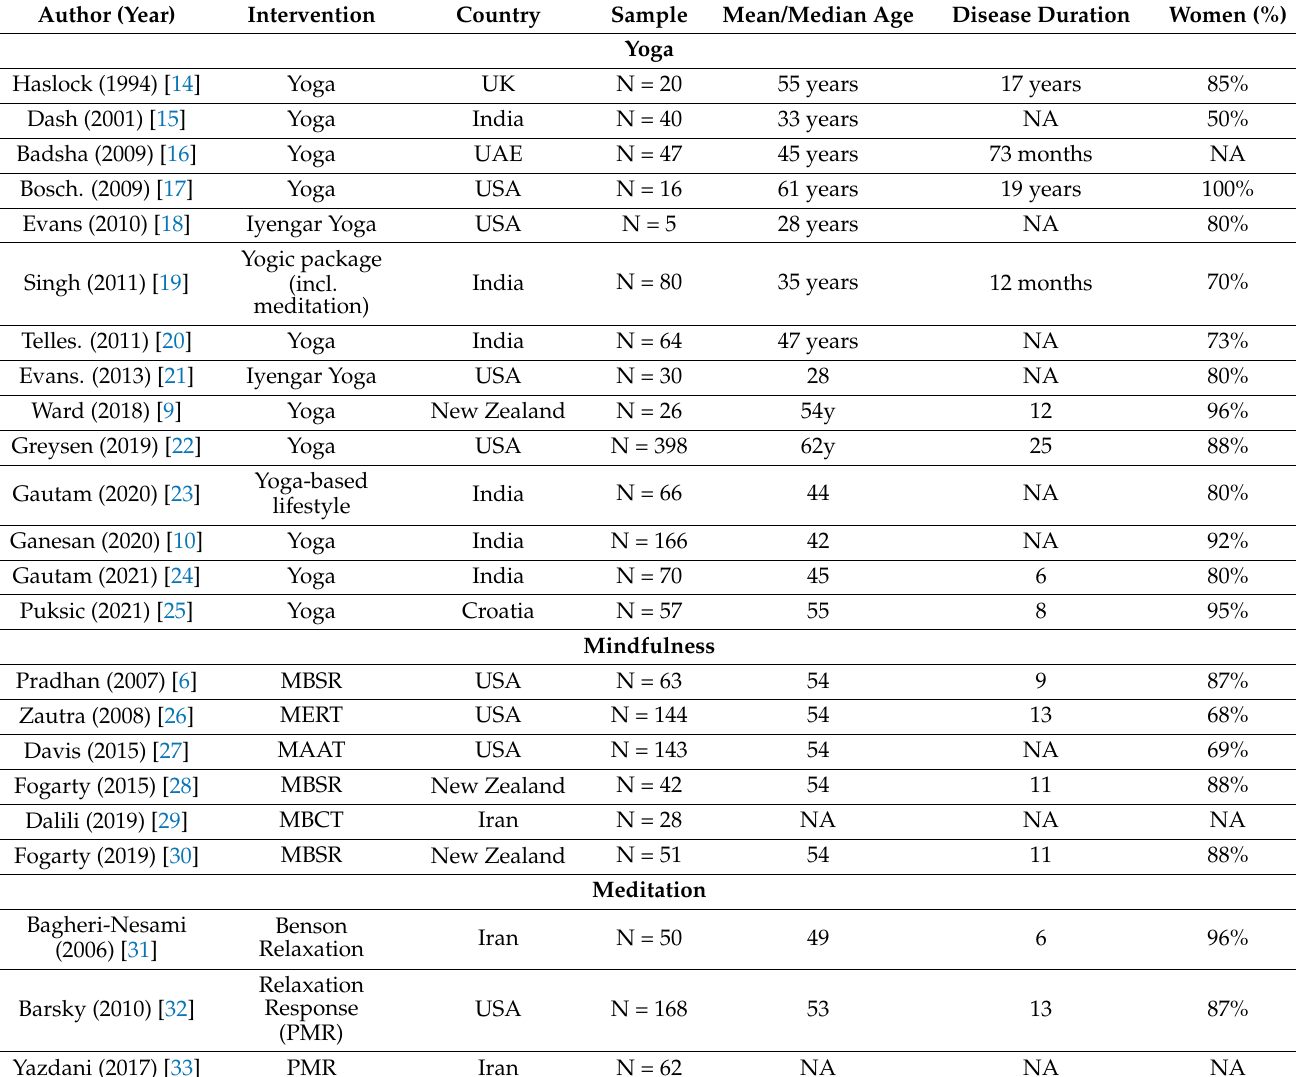
Table 1. Characteristics of the included studies, interventions, and participating patient